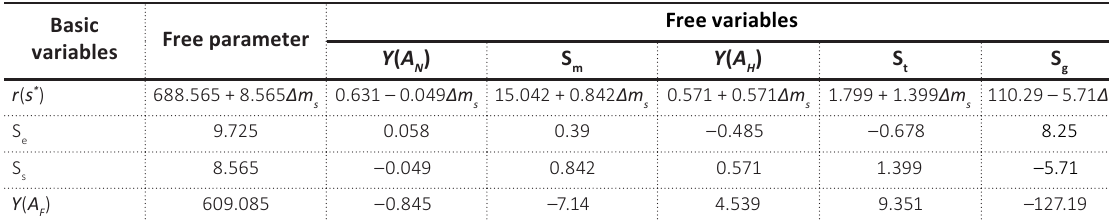
Table A6. Price variability for sports tourism services (green tourism destination)